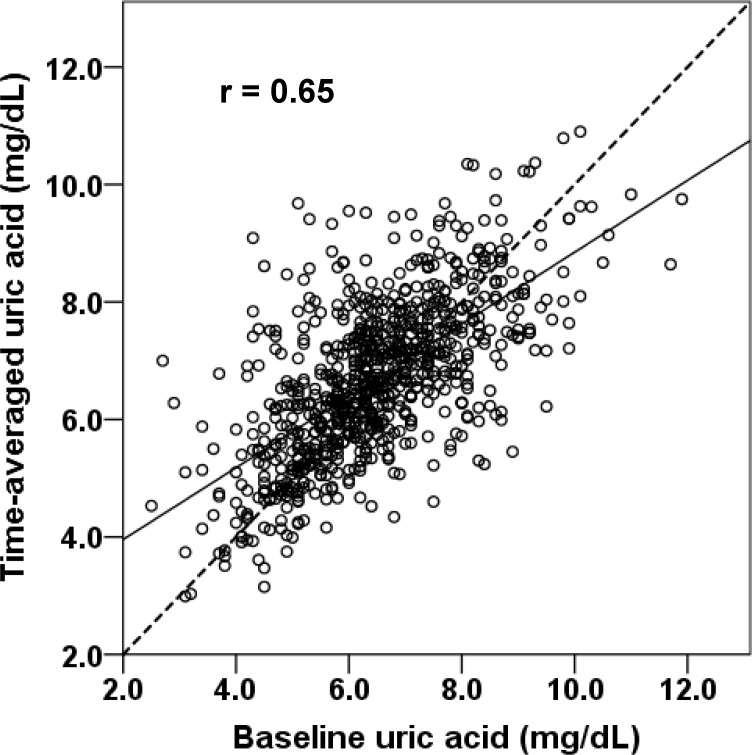
The relationship between baseline uric acid and time-averaged uric acid.The regression line is depicted in black line and a unity of the slope is overlapped in a dotted line. The correlation coefficients were 0.65 (p < 0.001). Two lines converge at serum uric acid 7.0 mg/dL. The time-averaged uric acid significantly decreased above the baseline uric acid 7.0 mg/dL and increased below the baseline uric acid 7.0 mg/dL.